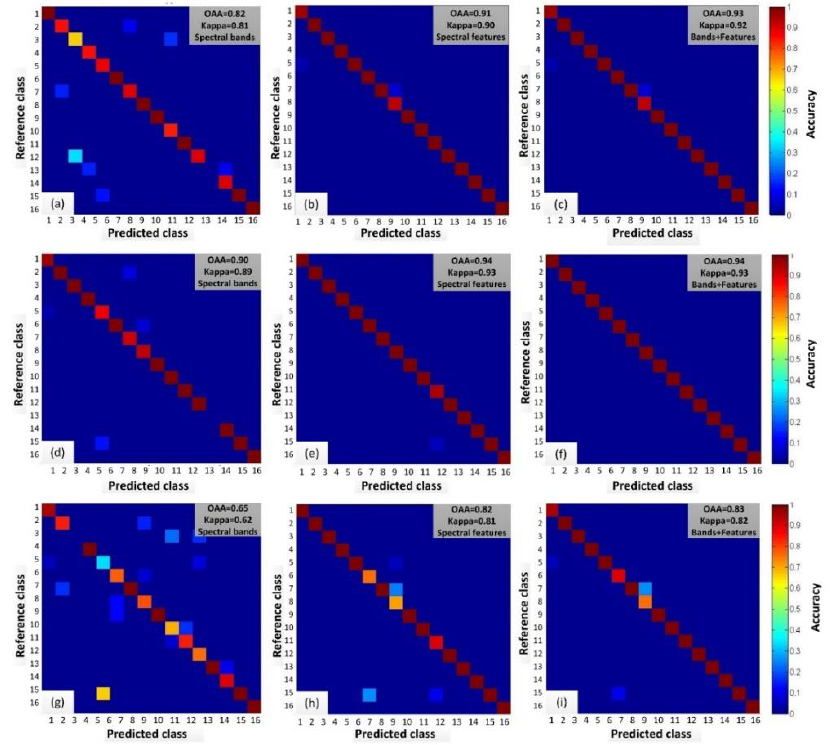
Figure 5. Visualization of crop classification results using a confusion matrix heat map. ( a–c are results using RF, d–f are results using GA-SVM, and g–i are results using K-nearest neighbors (KNN)).